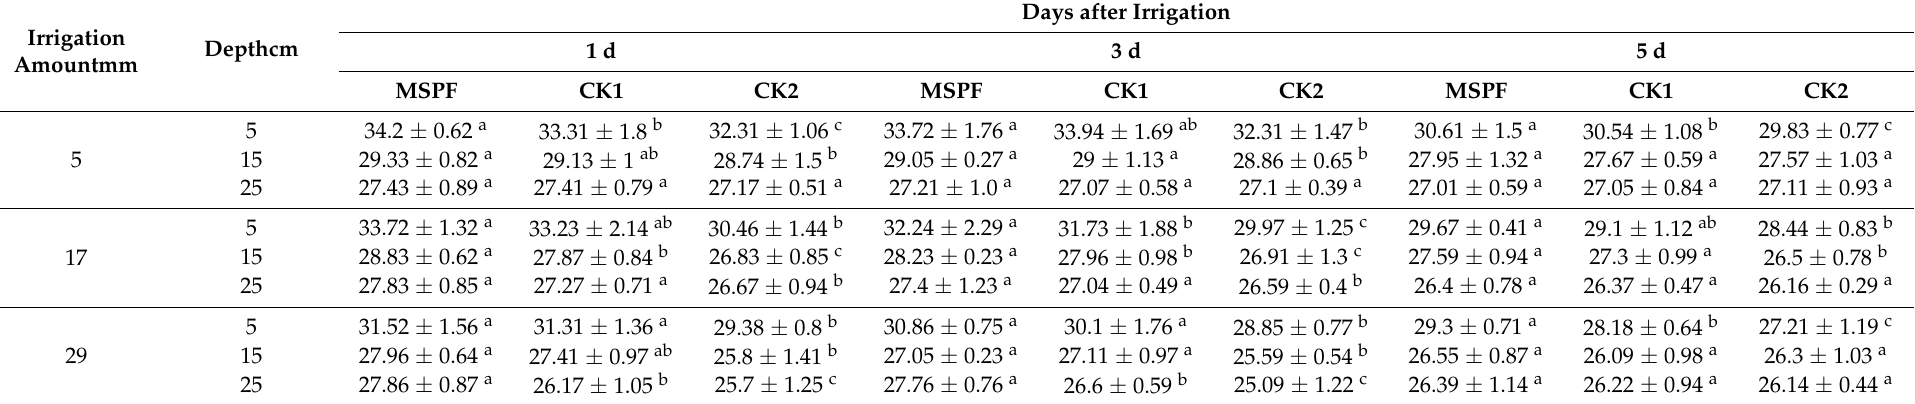
Table 3. Effect of different treatments on soil temperature at different depths ◦